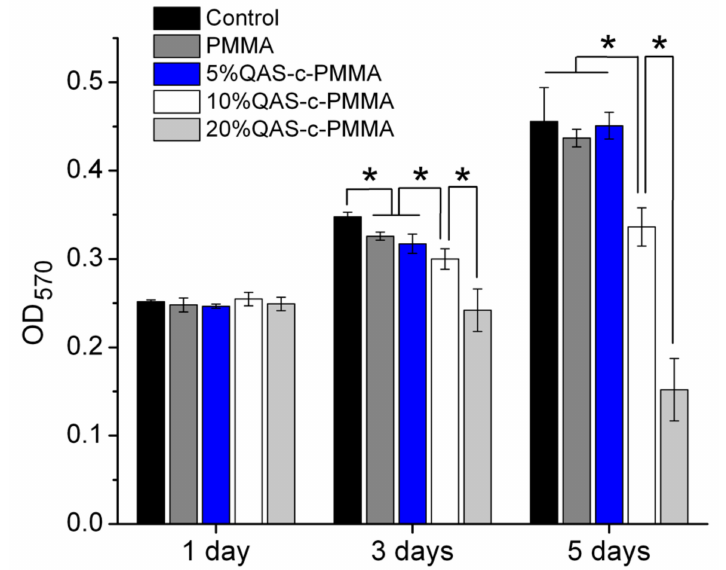
Figure 3. Cell viability test of PMMA, 5%QAS-c-PMMA, 10%QAS-c-PMMA, and 20%QAS-c-PMMA. The QAS-c-PMMA plates were placed at the bottom of Transwell inserts (diameter 6.5 mm, pore size 3.0 µ m) before the inserts were transferred to and incubated in 24-well culture plates, in which human gingival fibroblasts (HGF) at 5 × 10 4 cells per well had been seeded overnight at 37 ◦ C. Empty Transwell inserts served as a negative control group. After incubation for 1, 3, and 5 days, a 3-(4,5-dimethylthiazol-2-yl)-2,5-diphenyl tetrazolium bromide test was performed to examine the cell viability. * p <